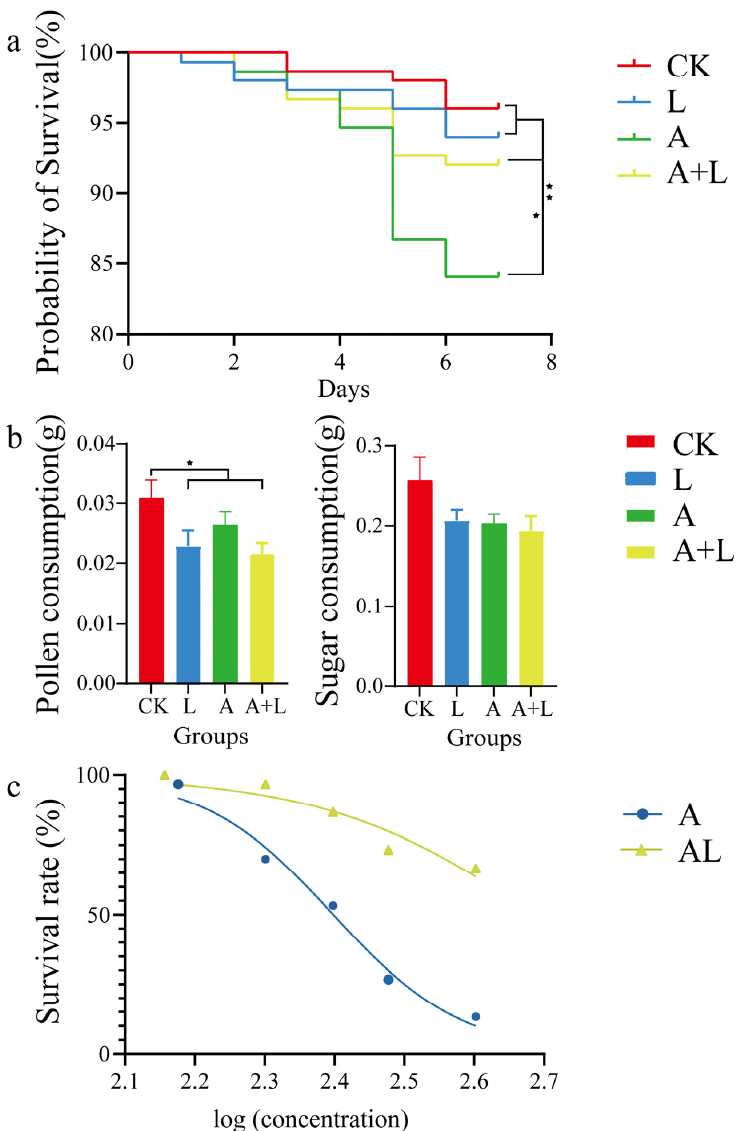
Figure 1. The effect of survival and food consumption under acetamiprid exportation and A. kunkeei addition for honeybees. ( a ) The survival of honeybees under acetamiprid exportation and A. kunkeei addition. ( b ) Consumption of food for a total of six days under acetamiprid exportation and A. kunkeei addition. ( c ) Impact of acute oral exposure to acetamiprid and of A. kunkeei addition. ‘*’ represents a statistically significant difference between the two groups at p < 0.05. ‘**’ represents a statistically significant difference between two groups at p <